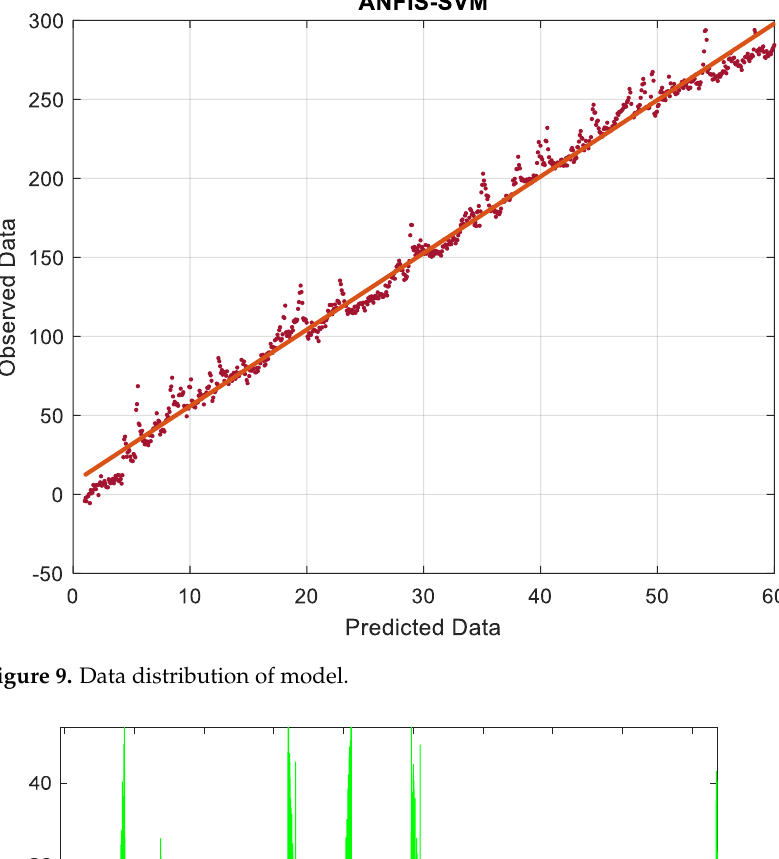
Figure 9. Data distribution of model.